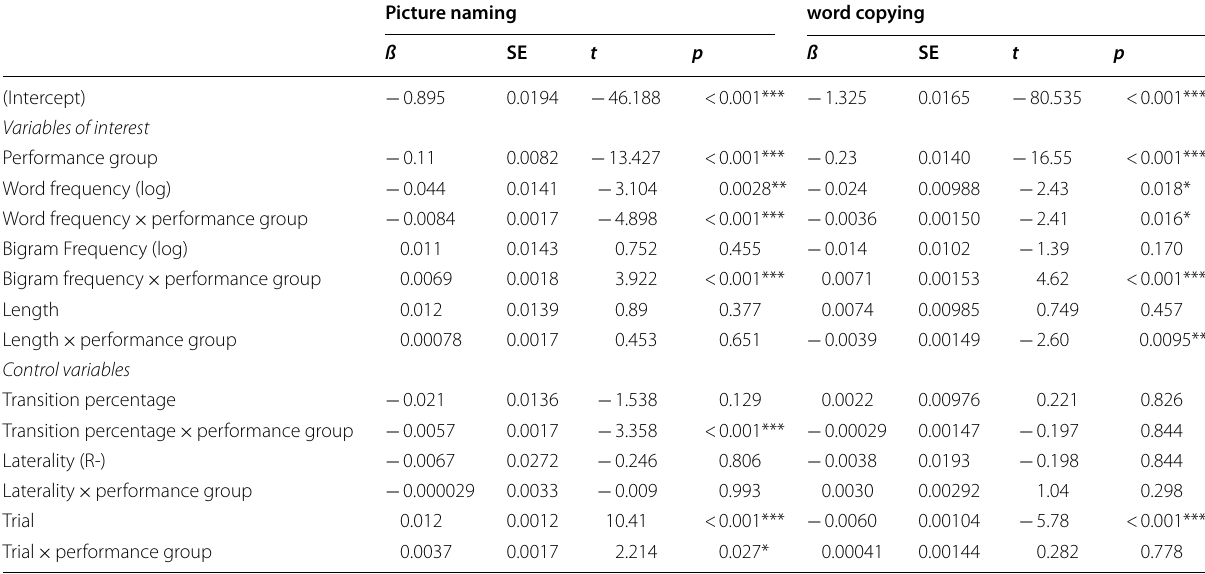
Performance group were coded as treatment contrasts